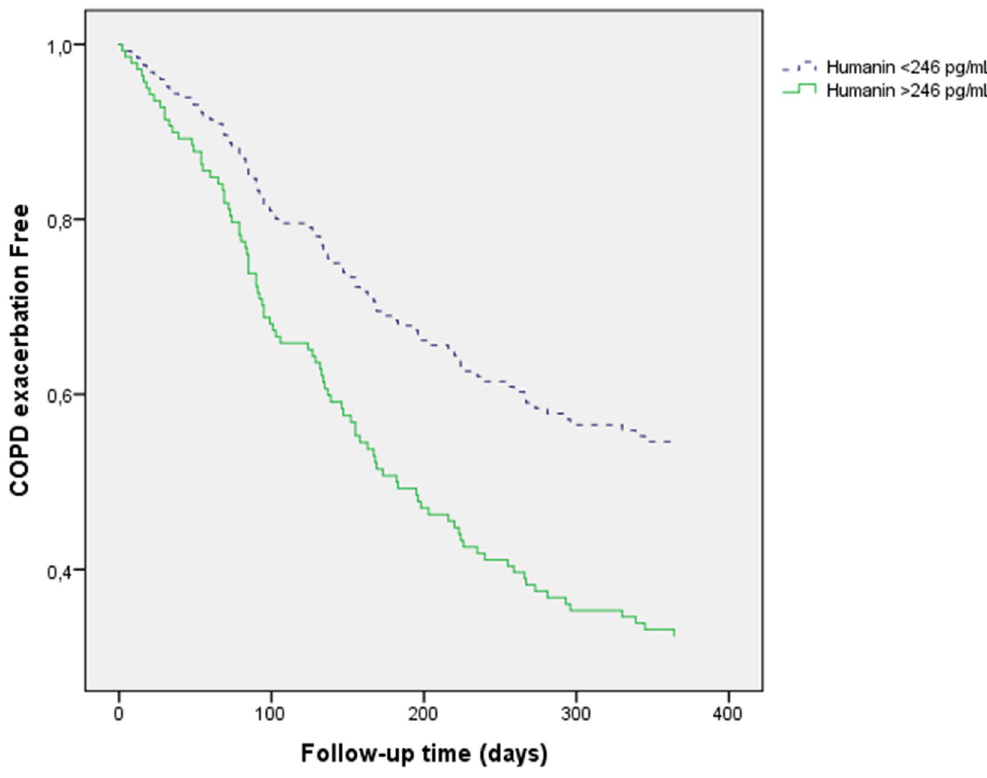
Figure 2. Serum HN levels as predictors of moderate COPD exacerbations.